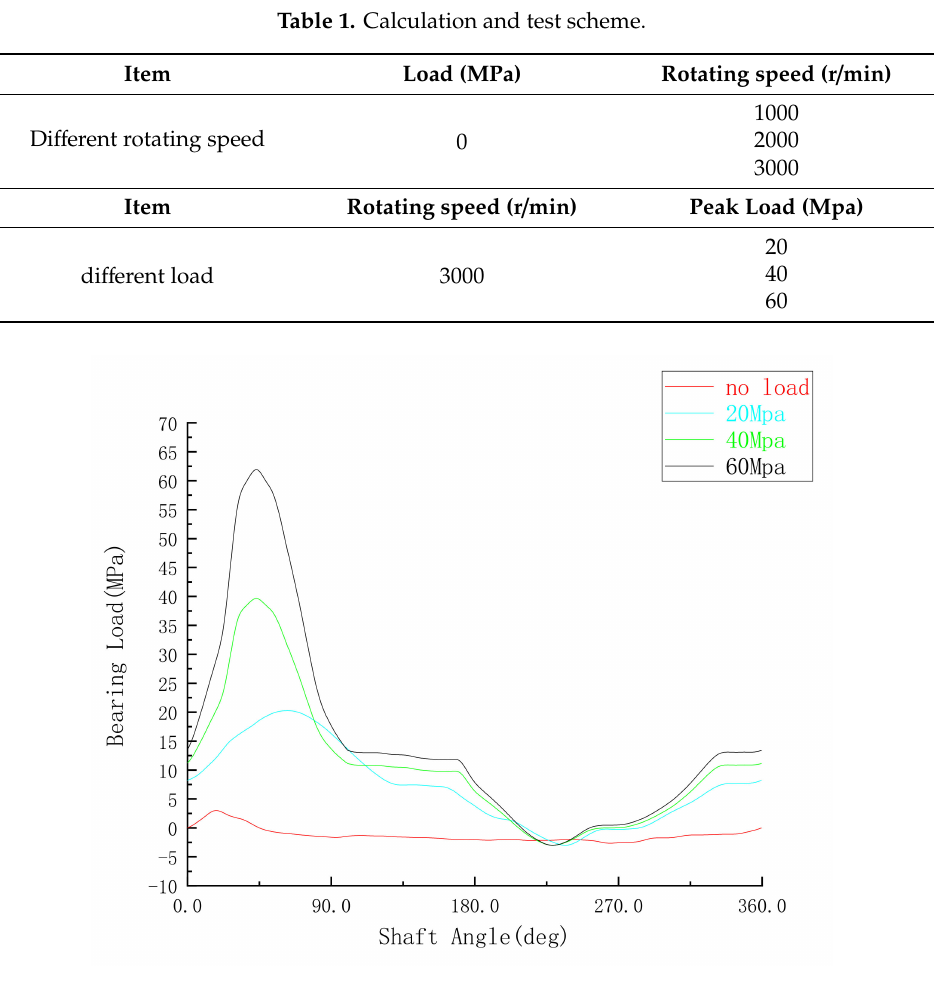
Figure 3. Load curves under the di ff erent working